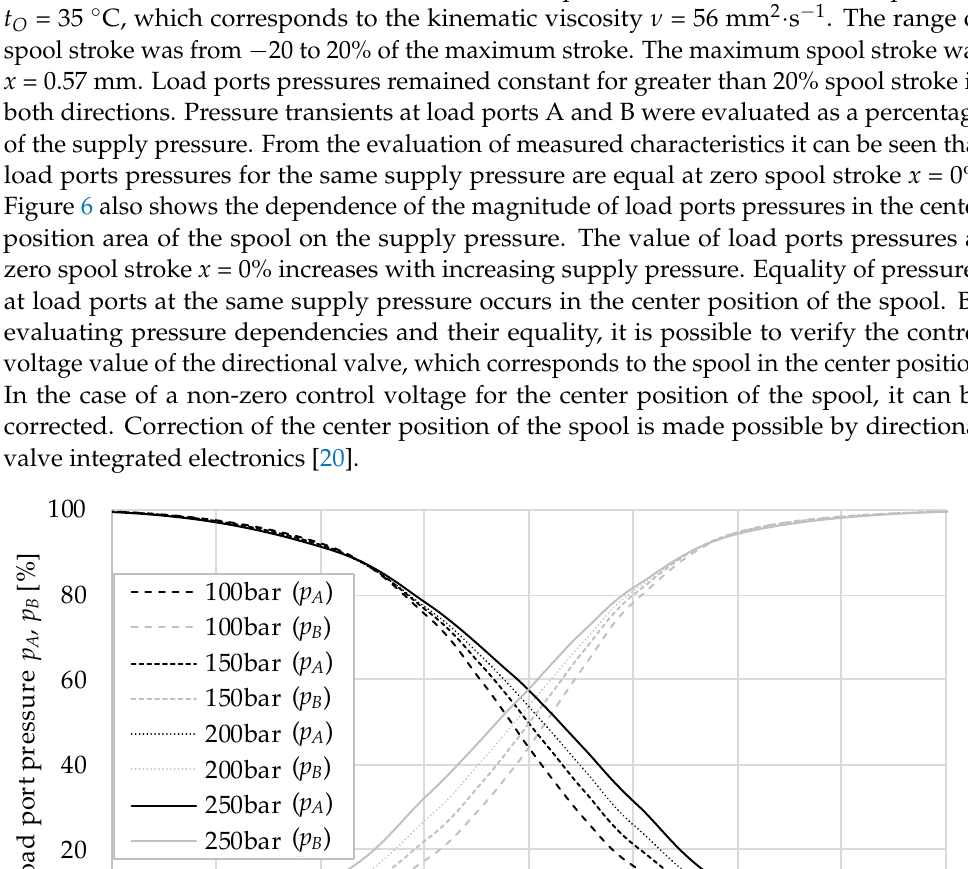
Figure 7. Blocked-line pressure sensitivity curves for different oil temperatures. 3.1.2. Leakage Flow Curve Figure 8 shows leakage flow curves for different supply pressure from 100 to 250 bar and for the constant oil temperature t O = 35 °C, which corresponds to the kinematic vis- cosity ν = 56 mm 2 ·s − 1 . Figure 8 also shows that the leakage flow Q L is maximum for the center position of the spool stroke and individual supply pressures decreases with the spool stroke in both directions. The leakage flow decrease is due to the increasing length